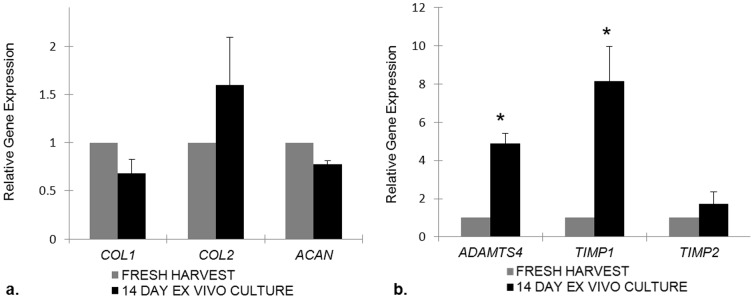
Real-time PCR analysis of 14 day murine IVD explants compared to freshly harvested IVD explants.Genes related to structural extracellular matrix production (a) and extracellular matrix remodeling genes (b) were analyzed. After 14 days in culture, murine IVD explants do not change the gene expression of the principal structural genes of the IVD, while ADAMTS4 and TIMP1 are significantly upregulated. Analysis was normalized to GAPDH. Results are presented relative to freshly harvested murine IVDs where the expression value was set to 1. * denotes statistical significance (p<0.05).